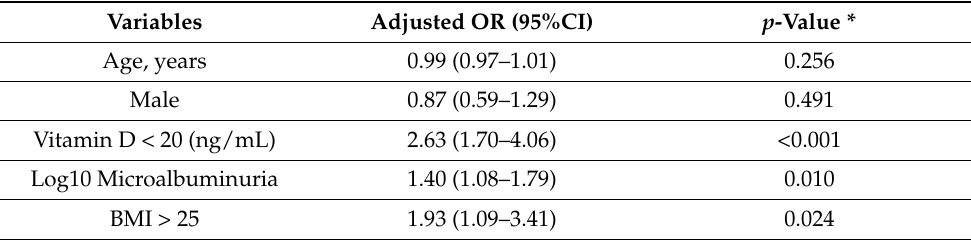
Table 4. Multivariate regression analysis for diabetic